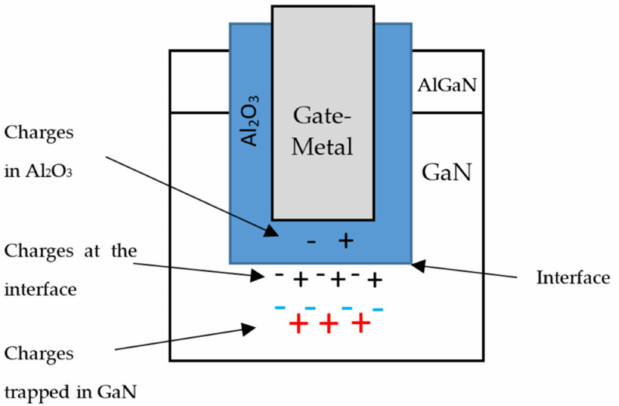
Figure 3. Location of charges around the